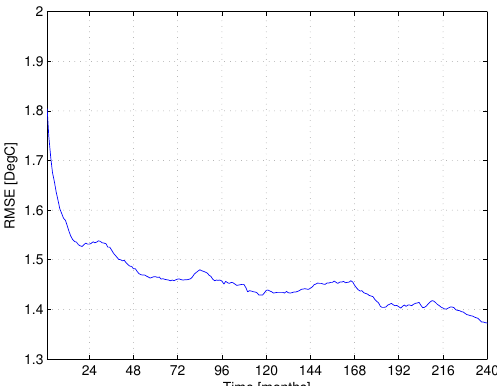
Figure 4. Global, area-weighted RMSE of the 2m temperature, dur- ing the 10-year validation period, as a function of the learning time. The presented RMSE was calculated for the EGA forecaster; how- ever, a similar trend was obtained for the EWA and LAA. In general, a longer learning period improves the forecaster